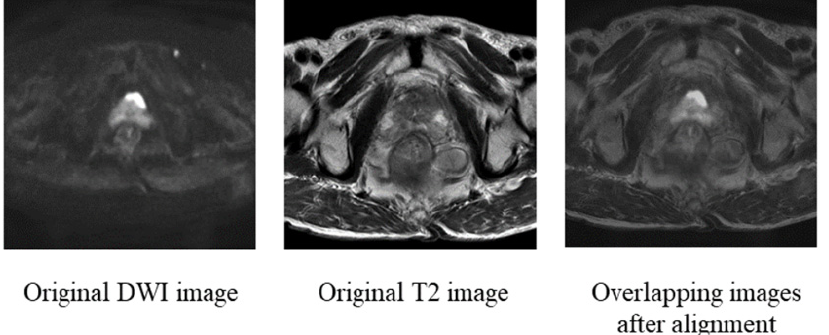
Figure 2. Examples of the alignment of DWI and T2 images are shown: (1) original T2 image, (2) original DWI image, and (3) aligned T2 image after being overlaid with the DWI